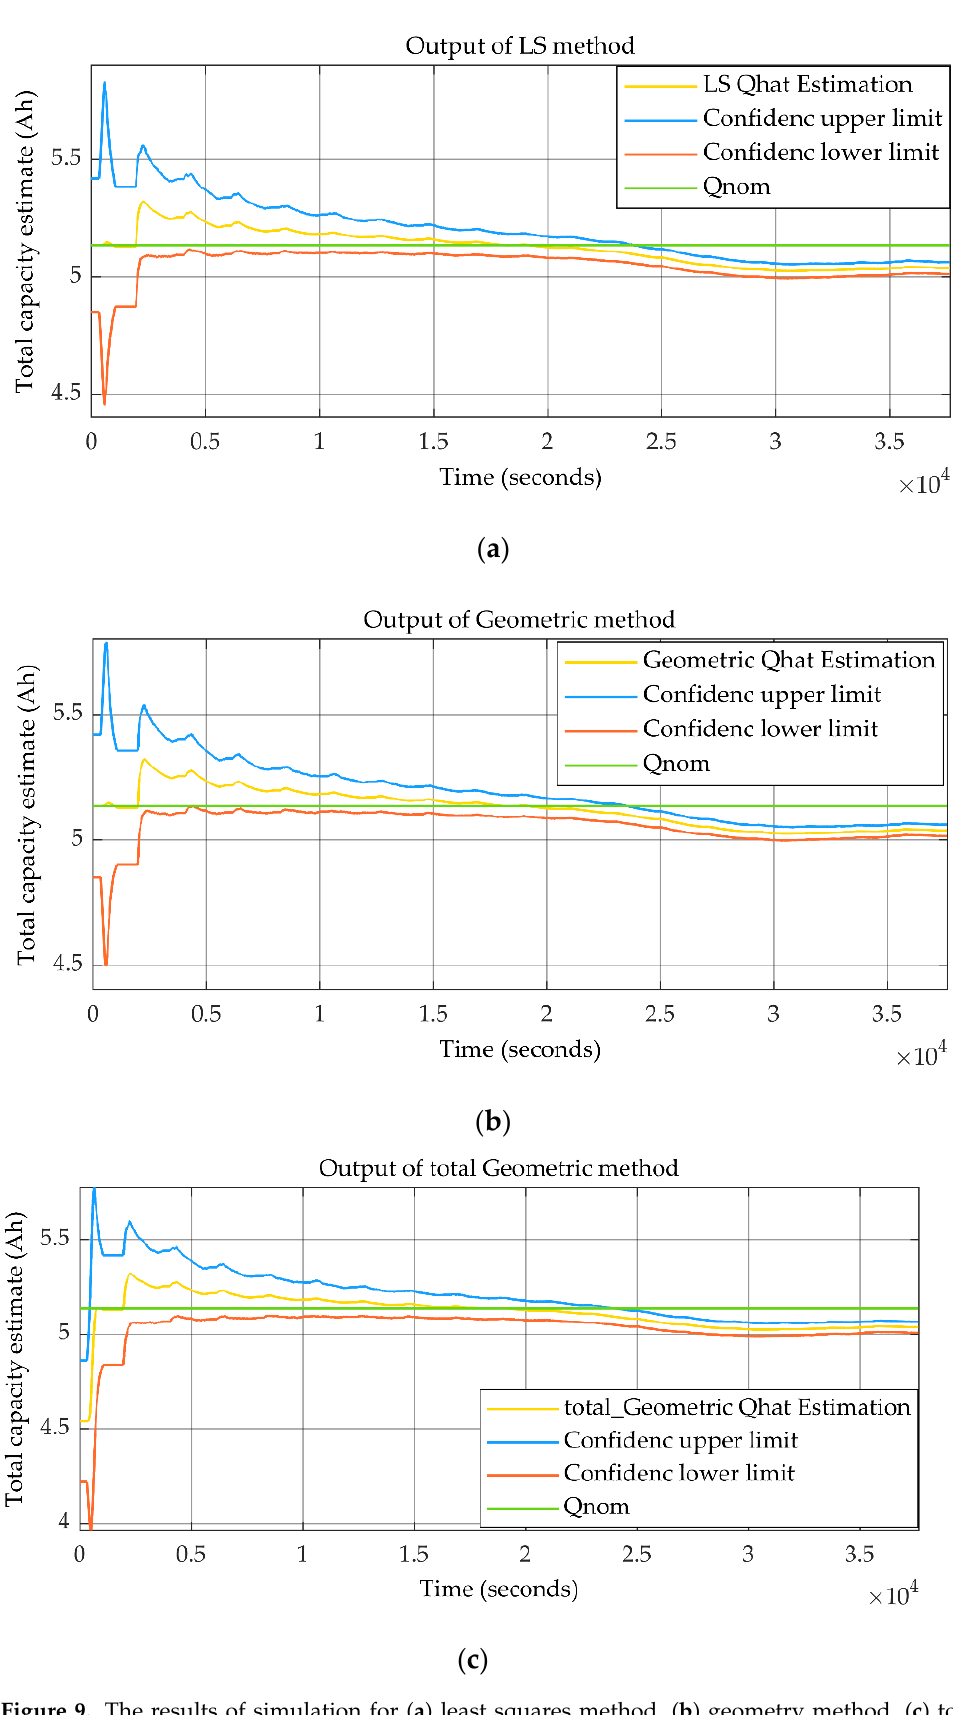
Figure 9. The results of simulation for ( a ) least squares method, ( b ) geometry method, ( c ) total geometry method.